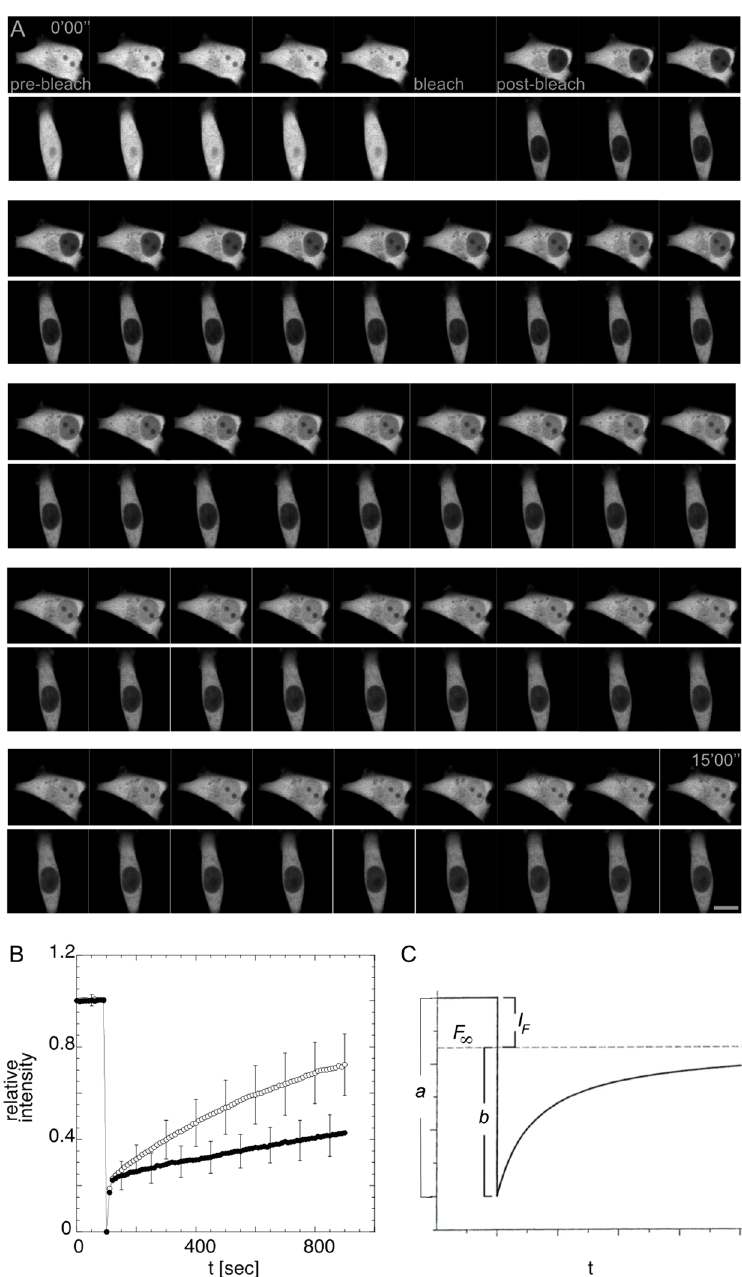
Figure 2. Dynamic distribution of CapG in normal and cancer cells. ( A ) Fluorescence recovery after photobleaching (FRAP) experiments show differences in dynamic nucleocytoplasmic distribution of CapG in breast cancer cell line (MDA-MB-231, upper panel) and immortalized normal breast epithelial cell line (MCF-12A, lower panel). Representative images from a time lapse, depicted only every second image from total of 90 images. Scale bar 10 µ m. ( B ) Plot of mean normalized relative fluorescence intensity in the cell nucleus over time for MCF-12A (filled circles) and MDA-MB-231 (open circles). Error bars indicated standard deviations [39]. ( C ) Schematic of Fluorescence after Photobleaching Recovery curve fit to a single exponential function. a is the fraction of fluorescence intensity initially bleached, b the fraction that recovers over time, and I F the immobile fraction, i.e., the fraction of immobile irreversibly bleached molecules that is not replaced by still fluorescent molecules. τ is the characteristic recovery time, i.e., the time by which two-thirds of the initial fluorescence intensity have been